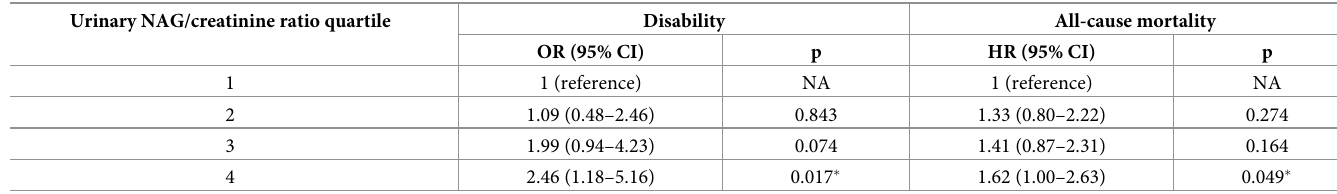
Table 7. Multivariable-adjusted odds ratios (ORs) a and hazard ratios (HRs) a for subsequent disability and all-cause mortality according to urinary N -acetyl- β - D - glucosaminidase activity–urinary creatinine concentration ratio (urinary NAG/creatinine ratio) quartile in participants without proteinuria. Urinary NAG/creatinine ratio